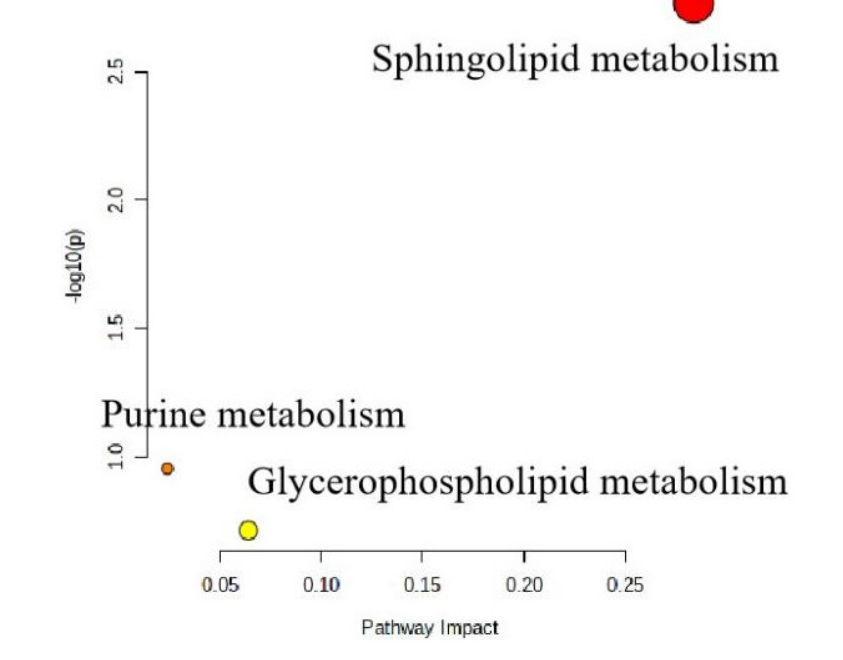
Figure 6. The metabolic pathway analysis of differential metabolites of plasma between the high − fat diet and high − fat diet + L. rhamnosus TR08 strain groups.